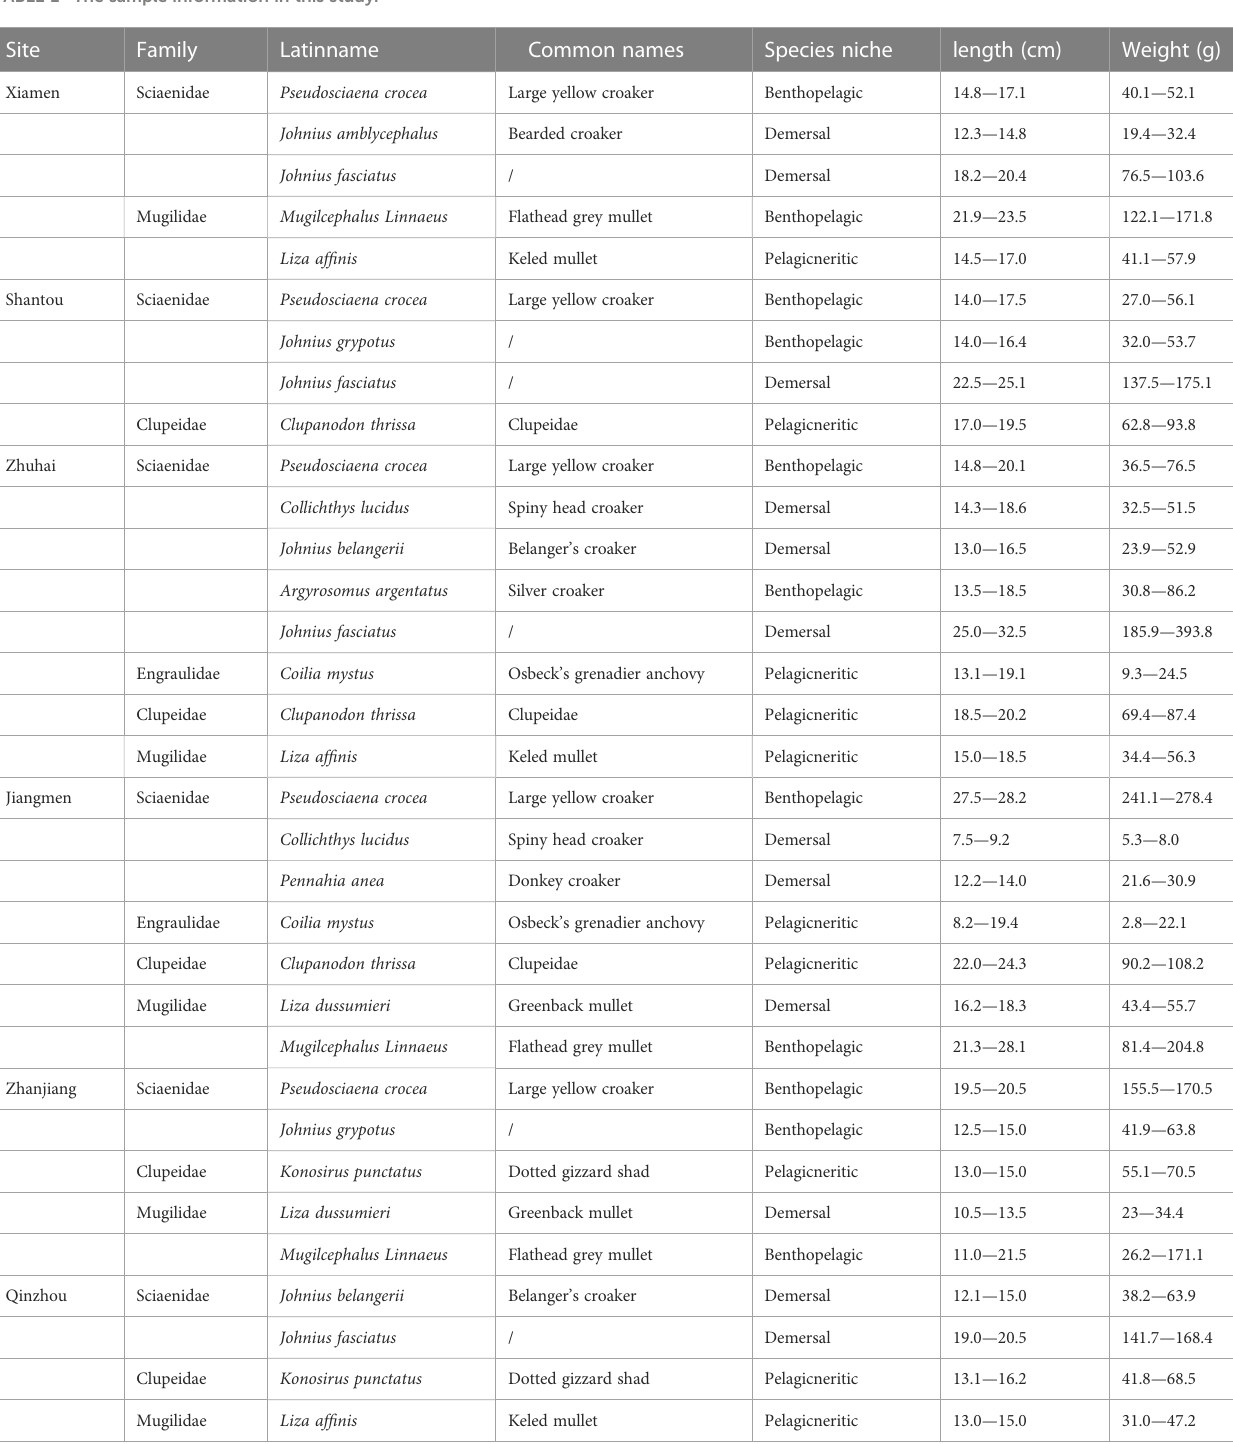
TABLE 1 The sample information in this